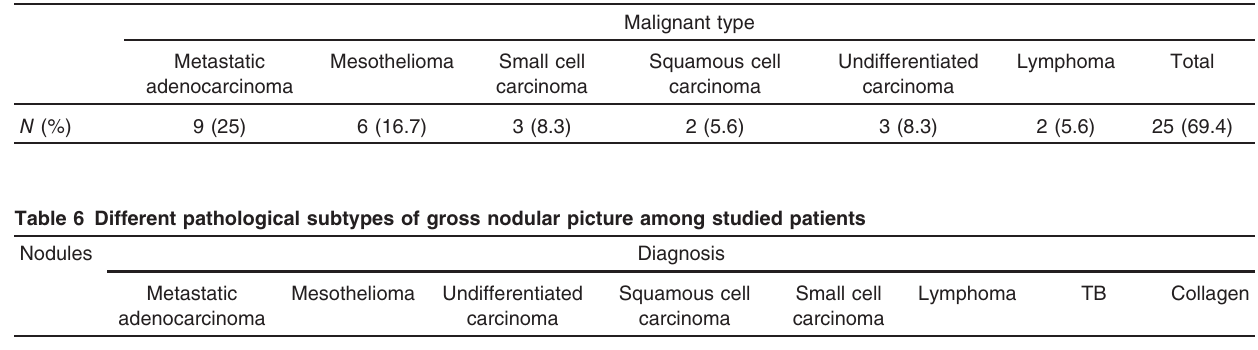
Table 5 Different pathological subtypes of malignant pleural effusion patients